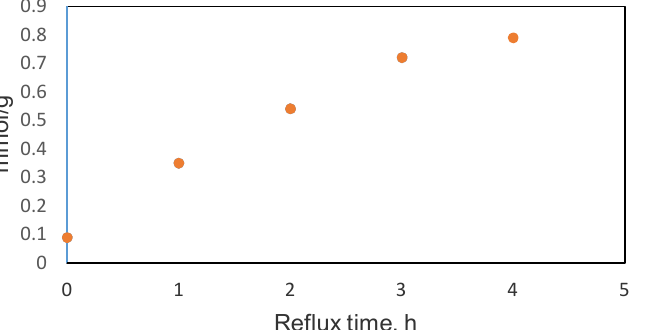
Figure 6. Correlation between the calculated amounts of carboxylic groups vs. reflux time (total reflux time 4 h).